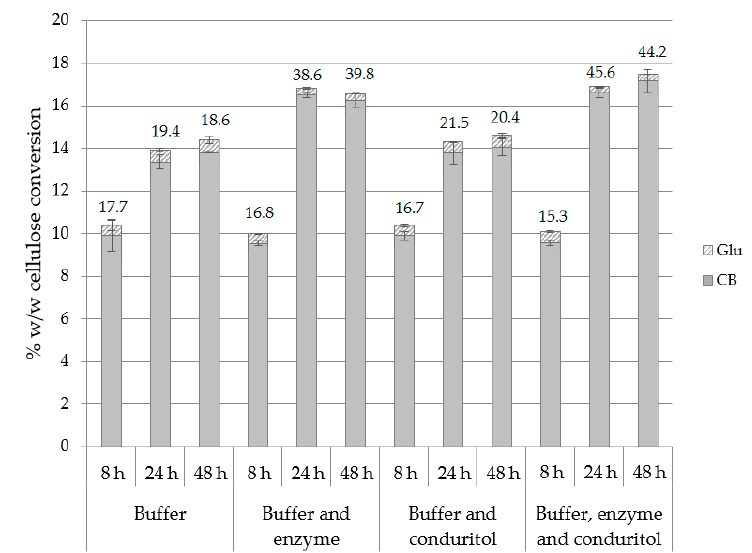
Figure 5. Cellulose conversion (% w/w) to CB and Glu after applying buffer exchange and/or supplementation with additional enzyme loading or conduritol-B-epoxide. The CB:Glu ratio is also described for 8, 24 and 48 h of hydrolysis.